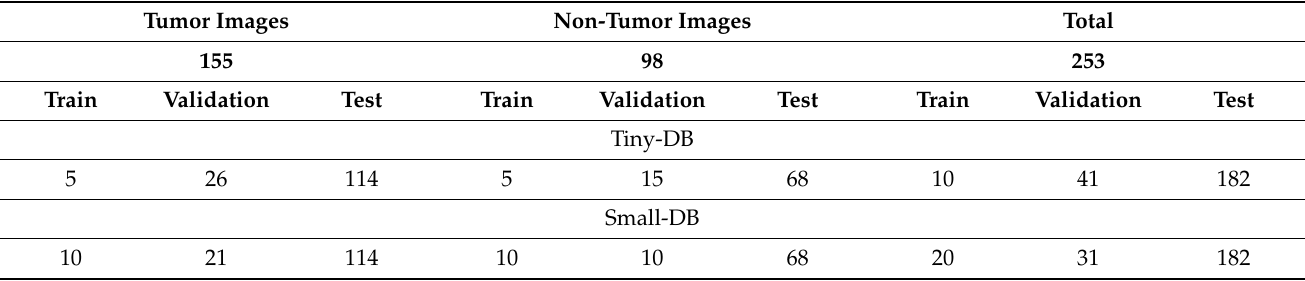
Table 4. Summary of images in the BT-Small